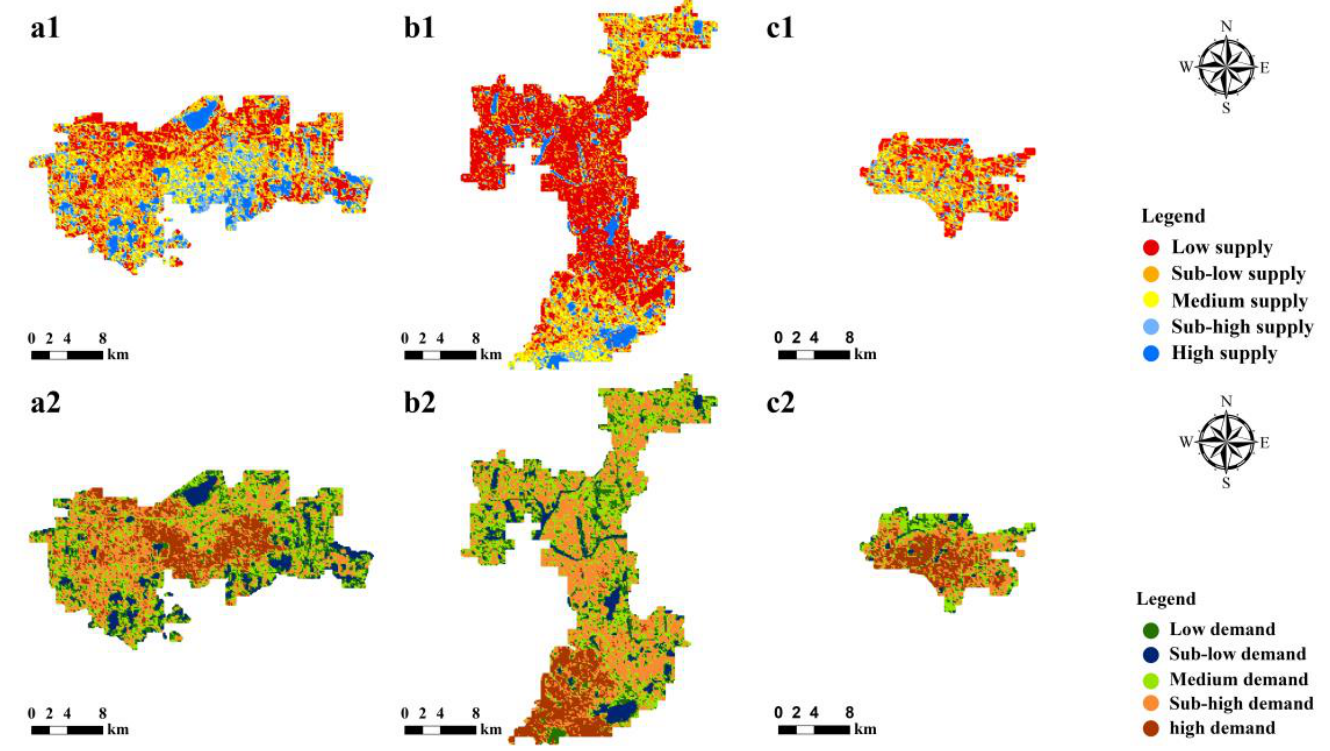
Figure 5. CIS and CID spatial distribution map: ( a1 ) Jinan CIS, ( b1 ) Qingdao CIS, ( c1 ) Heze CIS, ( a2 ) Jinan CID, ( b2 ) Qingdao CID, and ( c2 ) Heze CID.